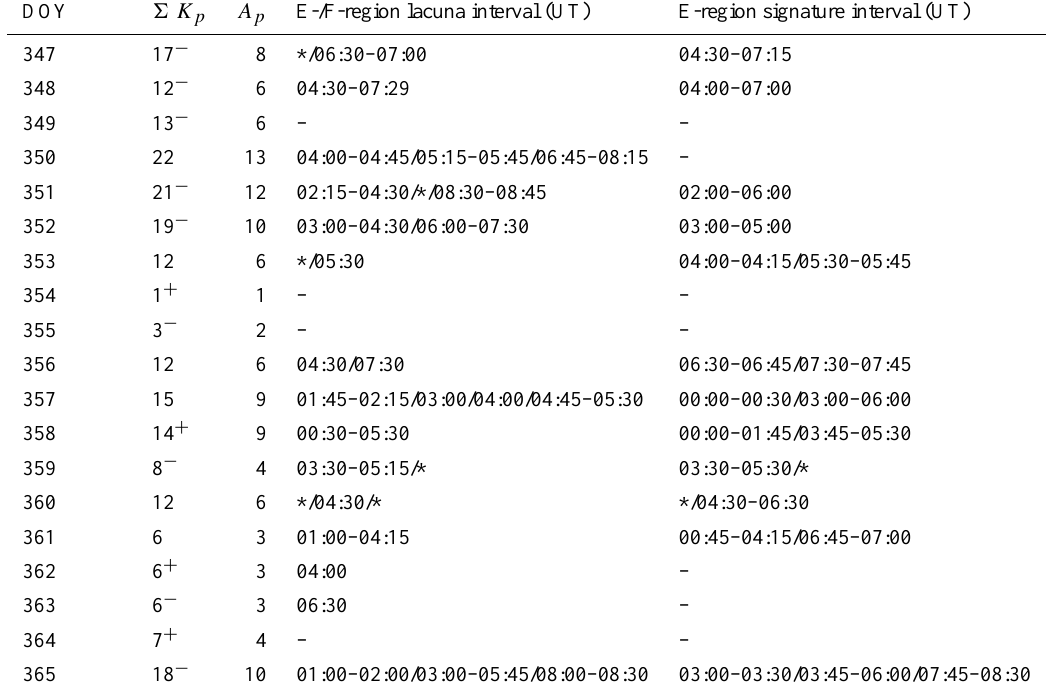
Table 1. Geophysical condition summary for the December 1996 solstice campaign, where the daily K p and A p indices and the SEC/lacuna and E-region Bragg scatter signature intervals are compared. A star indicates data gaps and a dash no observed occurrence. Note that ionograms and E-region drift measurements are initiated every 15 and 7min respectively, and LT=UT+07:22. DOY 6 K p A p E-/F-region lacuna interval